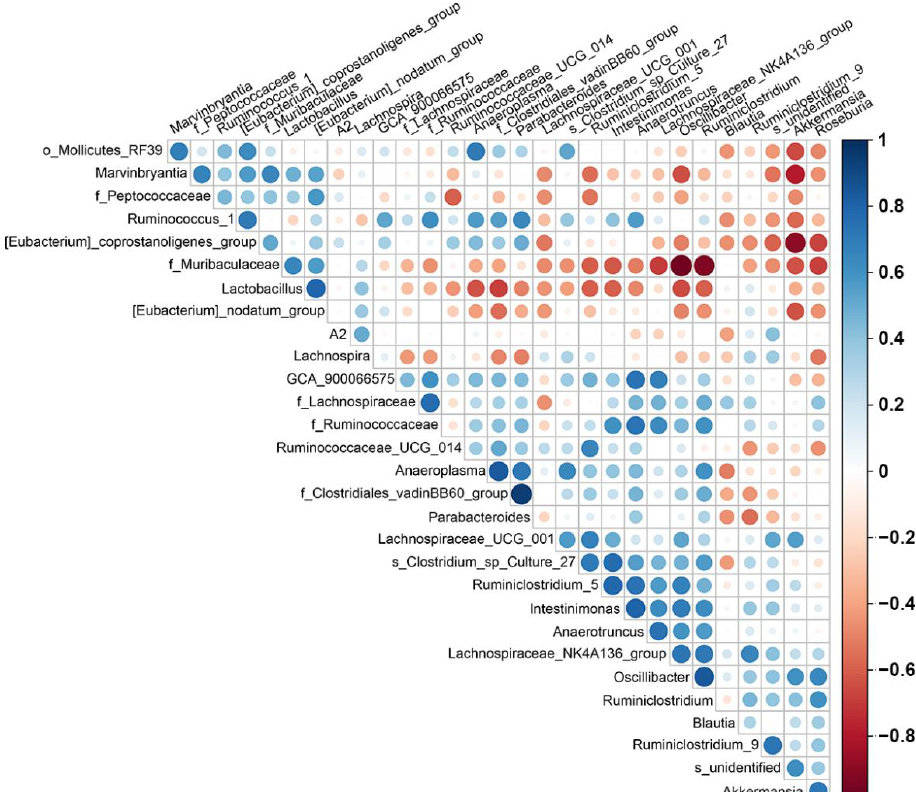
Figure 5. Spearman correlations between ASV-level microbial. Strong correlations are indicated by large circles, whereas weaker correlations are indicated by small circles. The colors of the circles denoted the nature of the correlation with dark blue indicating strong positive correlation and dark red indicating a strong negative correlation.